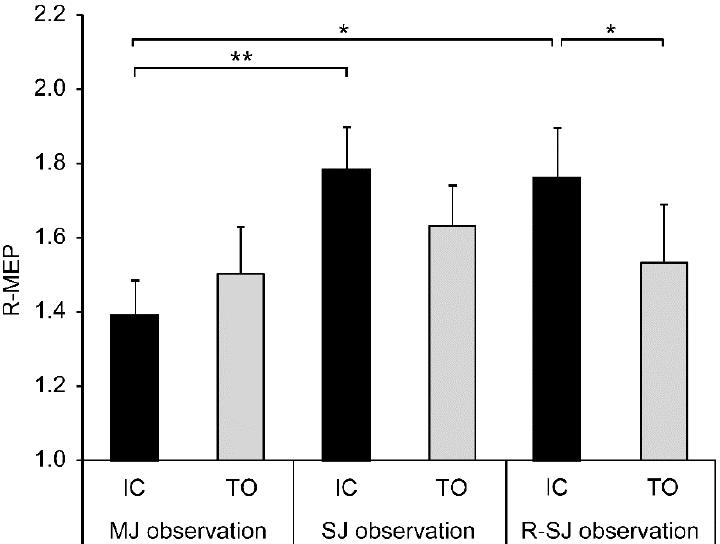
Figure 3. Mean values and standard errors of relative motor evoked potentials (R-MEPs) in two stimulus conditions (IC and TO) during three observation conditions (MJ, SJ, and R-SJ). The MEP values in each condition were divided by the average baseline MEP value and expressed as R-MEP. * p < 0.05; ** p < 0.01. IC, initial contact; TO, toe-off; MJ, multiple-joint; SJ, single-joint; R-SJ, restricted single-joint.